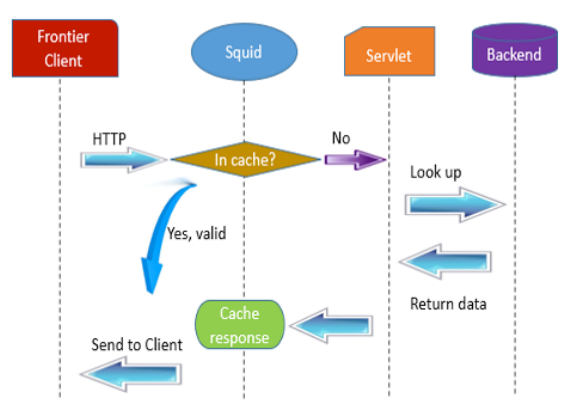
Fig. 4. Data caching of